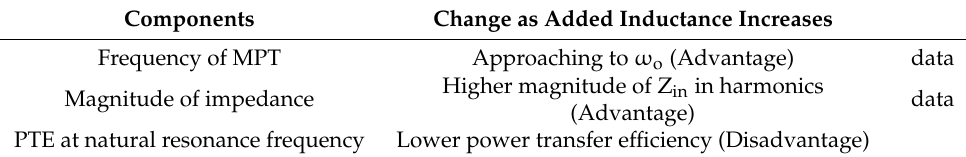
Table 2. Advantage and disadvantage of applying additional series inductors.